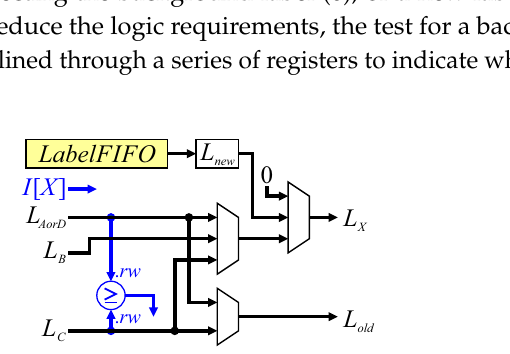
Figure 11. Architecture for label assignment. Blue represents control signal generation.